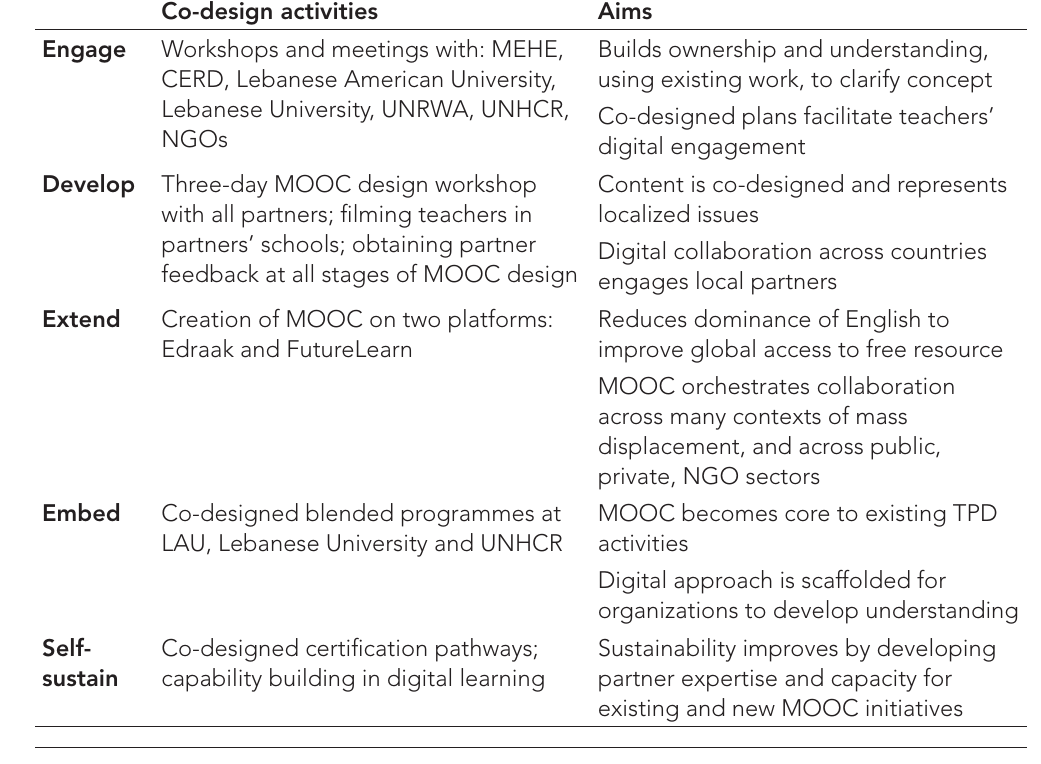
Table 1: Instantiation of theory of change model for TPD MOOC based on